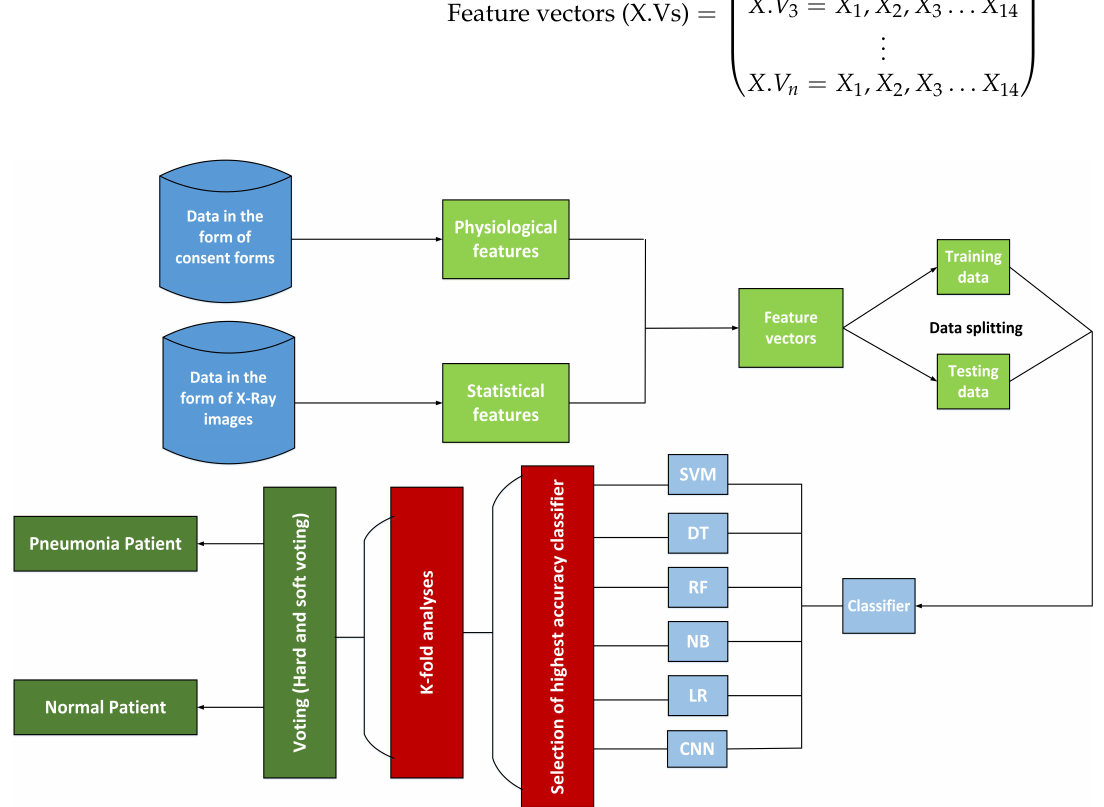
Figure 12. Flow diagram of the proposed